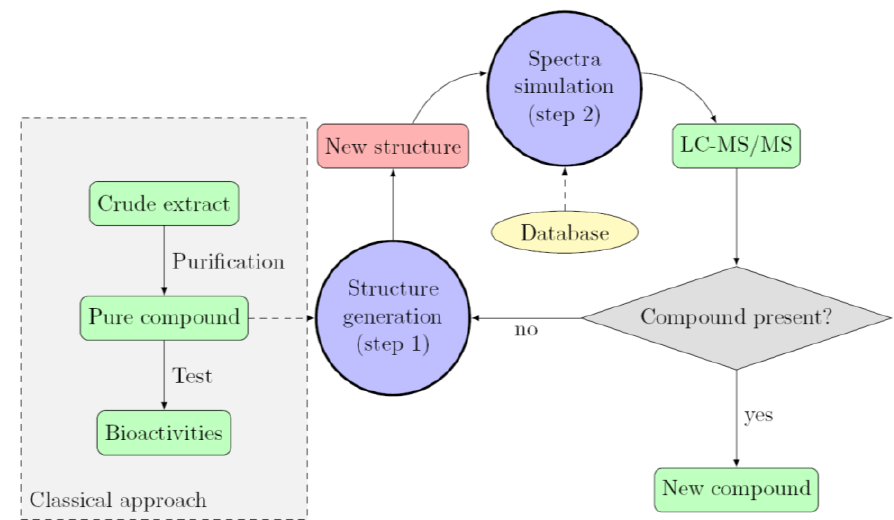
Figure 1. Proposed work-flow for the identification of new